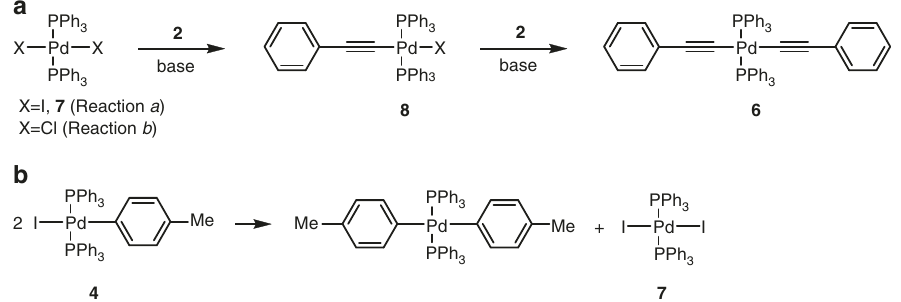
Fig. 3 Formation of some key catalytic intermediates. a Formation of acetylides 6 and 8 . b Homocoupling of 4 to give trans -[Pd II I 2 (PPh 3 ) 2 ] ( 7 )